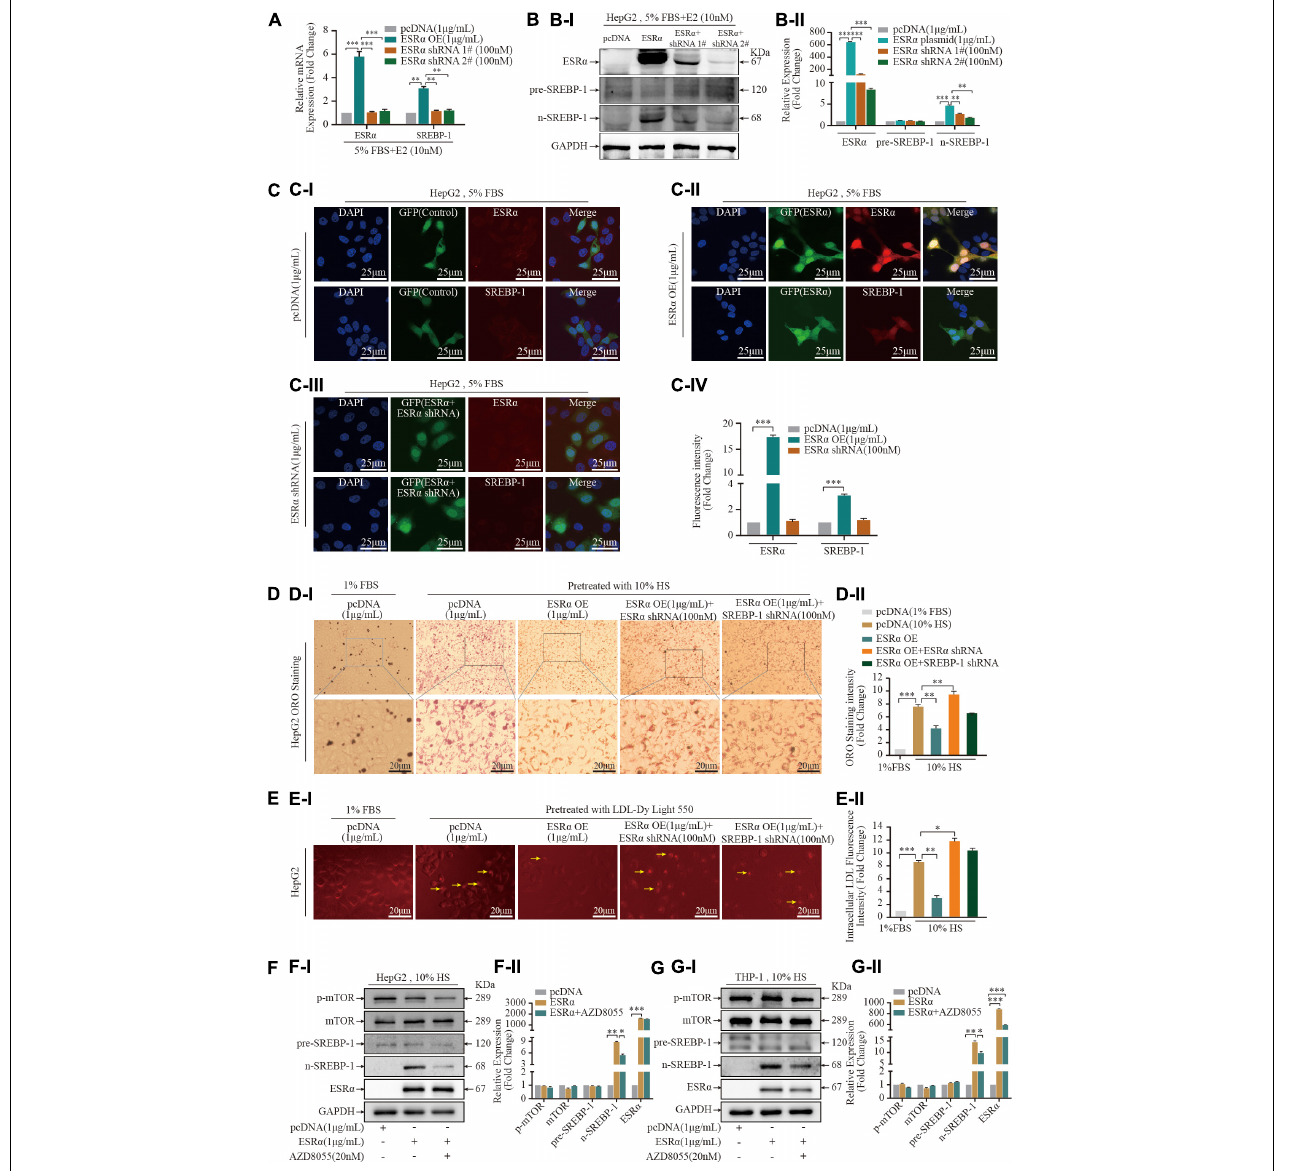
FIGURE 3 | Estrogen enhanced statin sensitivity both in vivo and in vitro . (A) HepG2 cells and THP-1 macrophages stimulated by 5% FBS and 10% HS with or without E2 treatment for 24 h, intracellular lipid accumulation in vitro was measured by the ORO staining assay. Representative ORO staining (AI) and quantification (AII) of red dot intensity in THP-1 cells after treatment with dissolving medium, E2, rosuvastatin, or E2 + rosuvastatin in the presence of 10% HS. FBS (5%)-treated THP-1 cells were set as the negative control ( n = 10 ∼ 20 cells/field/slice, n = 3 slices/group). (B) Eight-week-old ApoE − / − mice were subjected to ovariectomy. Seven days later, they were randomized to three groups: high-fat diet (HFD) group ( n = 8); HFD + E2 (0.25 mg/kg/day) ( n = 8); HFD + rosuvastatin (5 mg/kg/day) ( n = 8); HFD + E2 (0.25 mg/kg/day) + Rosuvastatin (5 mg/kg/day) ( n = 8). Treatments continued for 20 weeks until euthanasia. Bodyweights of mice at time of euthanasia were shown in violin plots. (C) After euthanasia, peripheral blood was collected from the abdominal aorta. Violin plots show the distribution of serum concentration of alanine aminotransferase (ALT) (CI) , aspartate aminotransferase (AST) (CII) . (D) Violin plots show the distribution of serum concentration of TC (DI) , TG (DII) , HDL-C (DIII) , and LDL-C (DIV) of the four groups of mice ( n = 8 mice/group). (E) Representative photomicrographs (EI) and quantification of plaques in the lumen (EII) of en face aortic arch and descending aorta of the four groups of mice ( n = 8 mice/group). (F) Aortic roots were prepared as rapid freezing sections and subjected to H&E staining for detection of plaque area of the three groups of mice. Representative images of H&E staining (FI) of the aortic root and plaque area (FII) of the four groups of mice ( n = 3 sections/mouse/group, n = 8 mice/group). (G) Liver tissue were prepared as rapid freezing section and subjected to ORO staining for detection of lipids accumulation. Representative images of liver ORO staining are shown (GI) ( n = 3 sections/mouse/group, n = 8 mice/group). Densitometric quantification was conducted using Image J and values are expressed as the fold change compared with control and are presented as mean ± SEM ( n = 8 mice/group). Student’s t -test was used to evaluate the significance in differences between two groups of observations, ∗ P < 0.05; ∗∗ P < 0.01; ∗∗∗ P < 0.001.